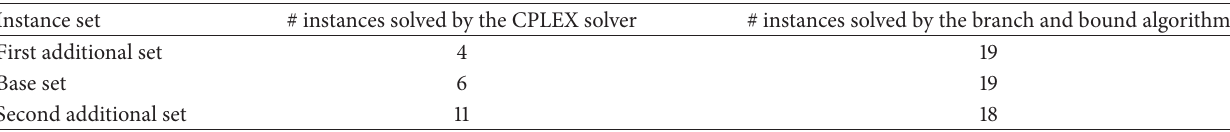
Table 3: Number of instances of each set of group III out of 20 solved to optimality in 10 seconds by the branch and bound algorithm and the CPLEX solver.